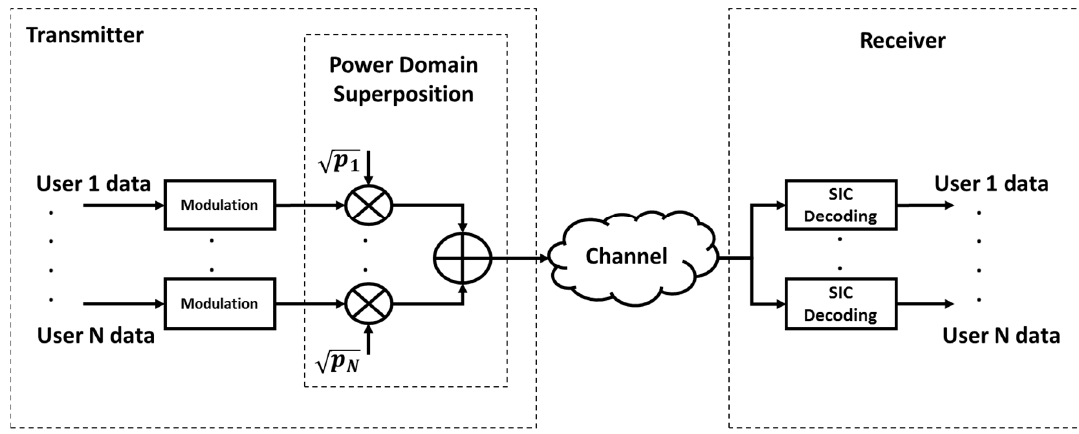
Figure 2. Block diagram of the conventional NOMA system.